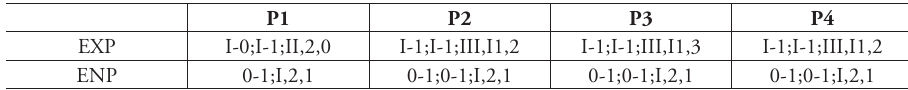
Figure 14. Odiliacletodes secundus sp. n., female holotype. A P3, anterior B P4, anterior. outer strong spinules; second and third segments with outer spinules only; first and sec- ond segments with one inner seta; third segment of P2 and P4 with two inner setae, two apical elements, and three outer spines, of P3 with three inner elements, two apical elements, and three outer spines, outermost apical element on third exopodal segment of P2-P4 spine-like. Endopod tri-segmented; of P2 and P3 as long as exopod, of P4 reach- ing insertion of subdistal inner seta; first and second segments subequal in length; second segment elongate, longest, with one inner and two apical setae, and one outer spine. Armature formula of P1-P4 as